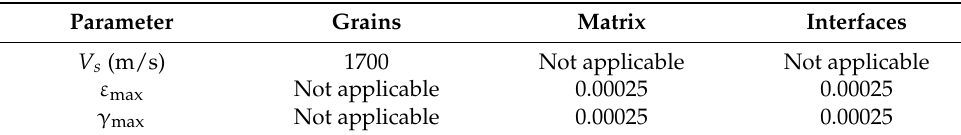
Table 2. Defined parameters controlling the separation of